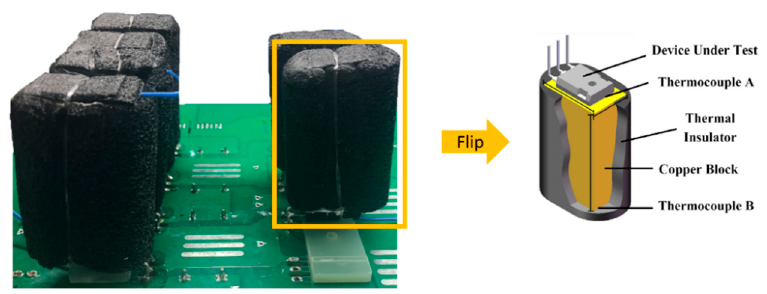
Figure 5. Loss measurement device.